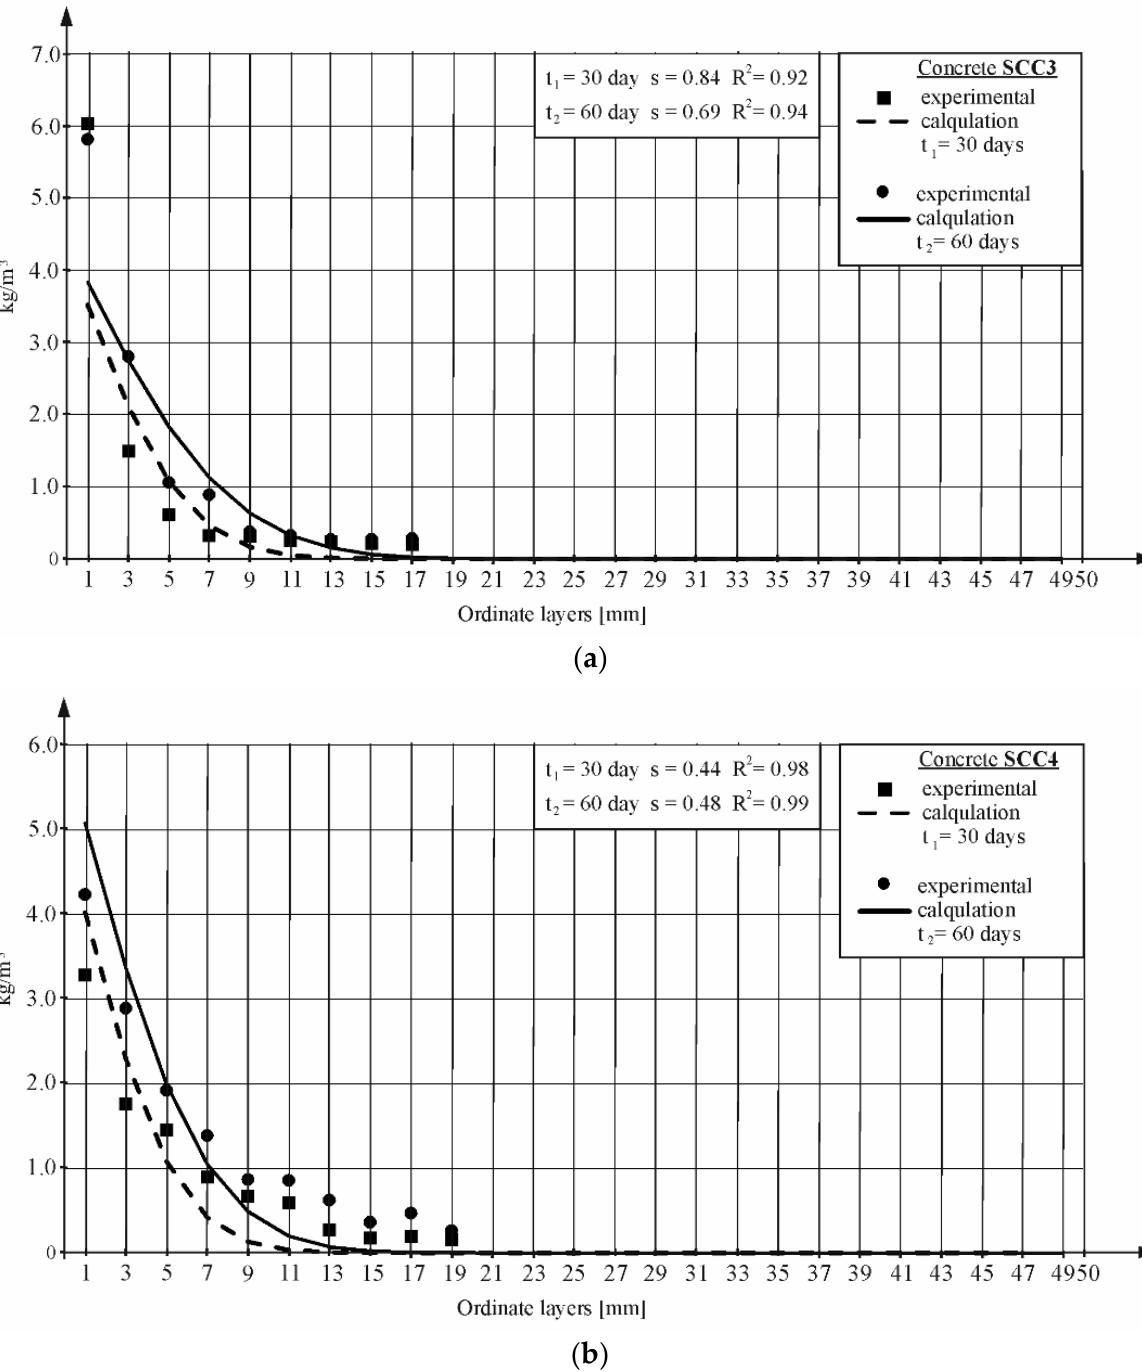
Figure 8. Chloride ion profiles were determined in diffusion tests in time t 1 , t 2 , and t 3 and calculated using the Equations (4) and (5), HSC1 concrete (TD1 and TD2). 4.5. Comparison of the Value of the Diffusion Coefficient Obtained with Different Methods Table 8 lists the values of the diffusion and migration coefficient determined by various methods. The table contains the values of the diffusion coefficient 𝐷 𝑁𝐸 ̅̅̅̅̅ deter- mined based on the charge measured during the migration test according to the standard ASTM C1202-97 [6] after applying the Nernst – Einstein Equation (1) (RCPT1). The next coefficient, 𝐷 𝑇 , as specified in the standard NT BUILD 492 [14], was computed based on migration tests, and the depth of chloride ion penetration was determined by the color- imetric method using Equation (2) (RCPT2). Successive values of the migration 𝐷 𝑚𝑖𝑔𝑟1 (NSC1) and diffusion coefficient 𝐷 𝑑𝑖𝑓1 (NSC2) were determined using the method of fitting the concentration curve plotted according to Equation (2) to the results obtained in the migration test conducted according to the standard NT BUILD 492 [14]. Equation (2), which, in a simplified manner, considers a certain multiplier linking the diffusion